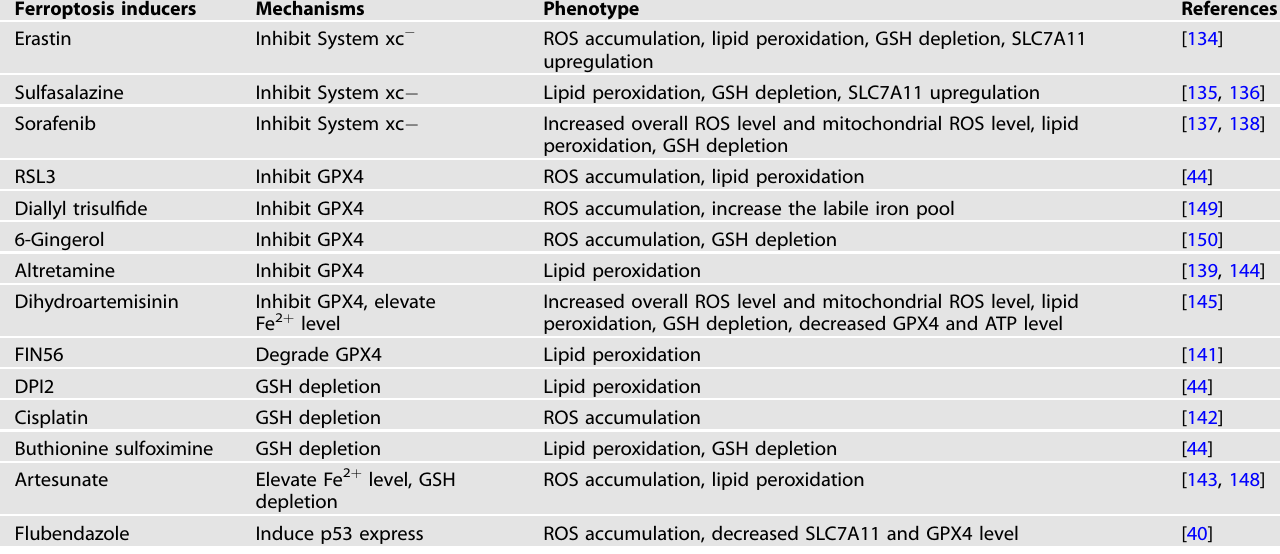
Table 2. Application and mechanism of ferroptosis inducers. Ferroptosis inducers Mechanisms